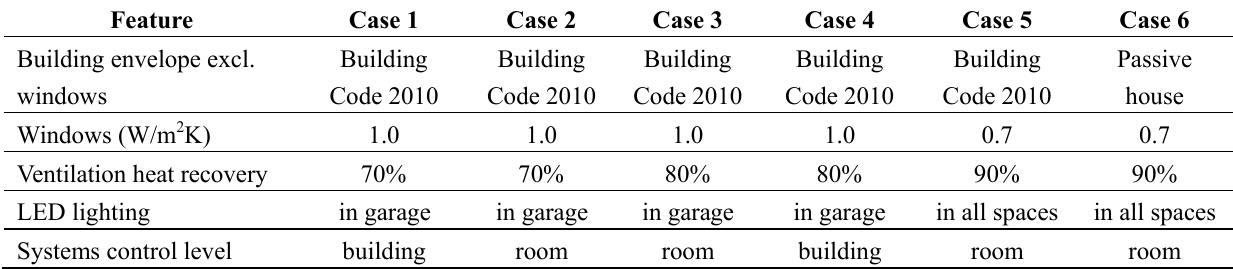
Table 1. Studied design alternatives. The control systems include ventilation and lightning. Feature